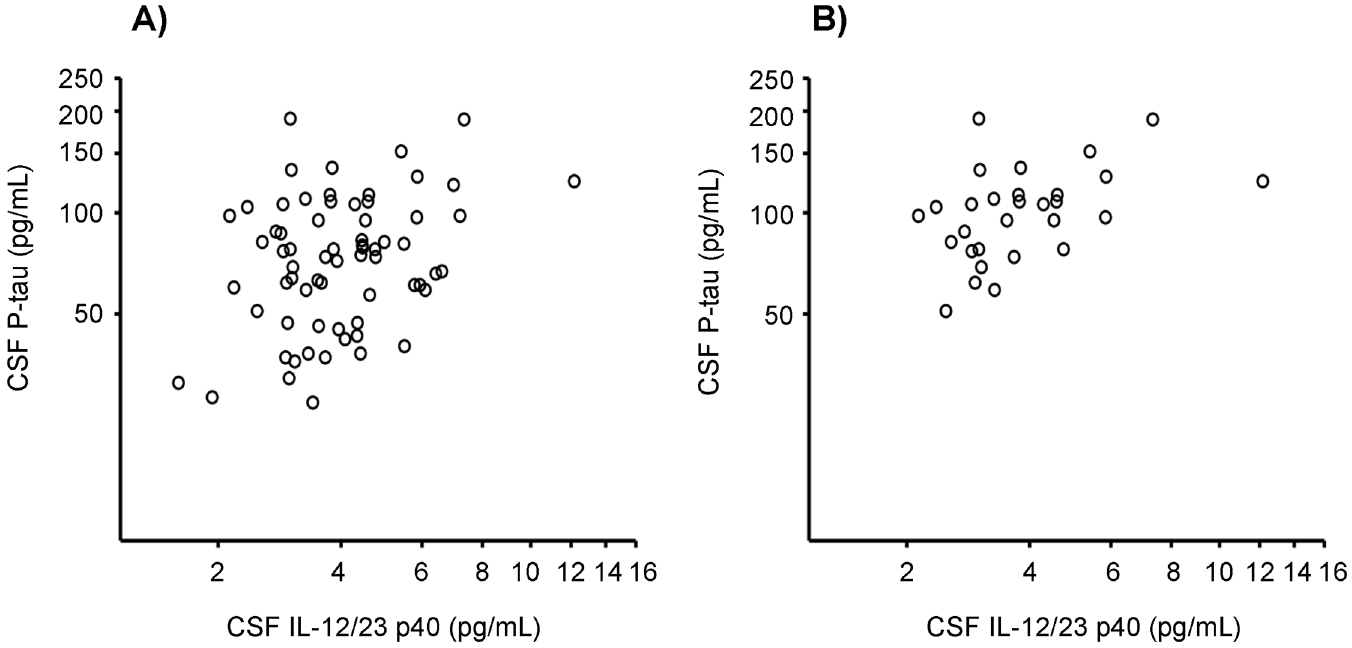
Fig 2. CSF IL-12/23 p40 correlatespositively with the CSF AD biomarker phosphorylated tau protein (P-tau). (A) In the total study population (n = 70; r = 0.25, p < 0.05) as well as (B) in the AD group (n = 30; r = 0.46, p = 0.01), CSF IL-12/23 p40 concentration correlated positivelywith CSF P-tau concentration. Note the logarithmicscale on both the x-axis and the y-axis. Correlationswere sought using the Spearman rank order correlationtest.